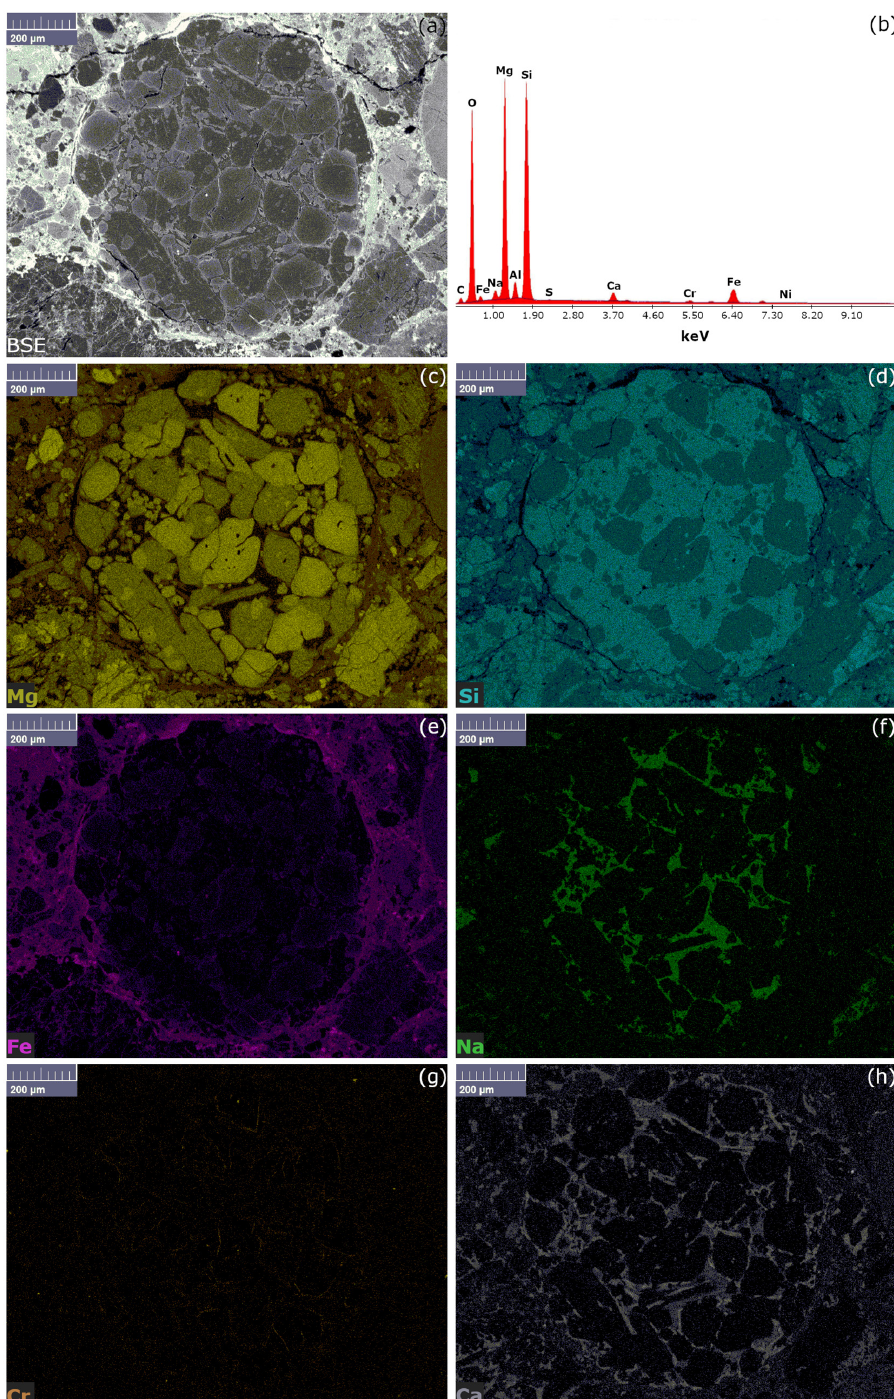
Figure 3. SEM-EDS results of chondrule A: ( a ) BSE image of the chondrule; ( b ) EDS spectrum corresponding to the sample’s area visible in ( a ); ( c ) Mg EDS map; ( d ) Si EDS map; ( e ) Fe EDS map; ( f ) Na EDS map; ( g ) Cr EDS map, ( h ) Ca EDS map.